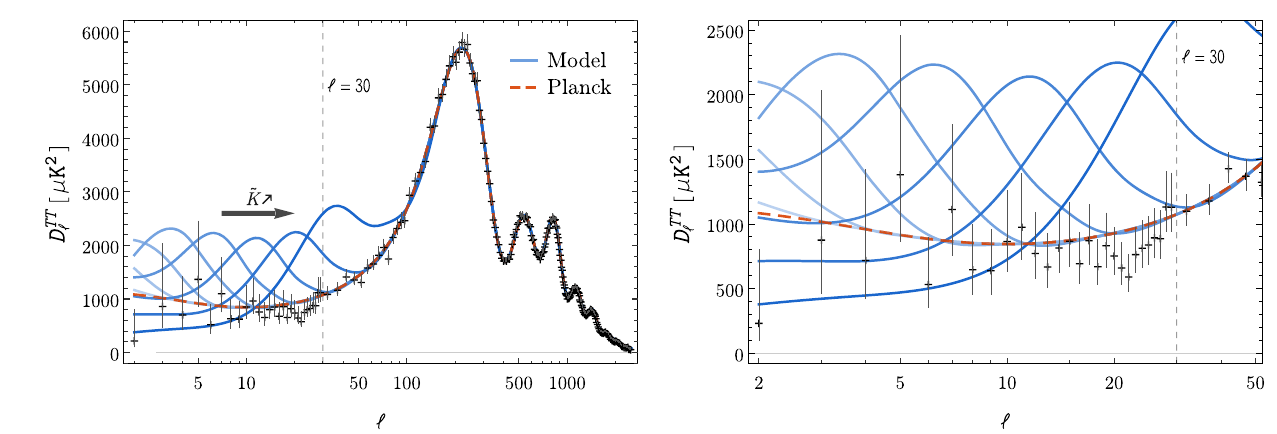
Fig. 5 The shape of P R for the model (3.14) leads to the suppres- sion of the angular power spectrum D TT (cid:18) at low multipoles and to the appearance of an extra peak in an intermediate region, while for large multipoles a good fit to the observational data is achieved. The suppres- sion at low multipoles is observed only for ˜ K (cid:16) ( 10 k 0 /